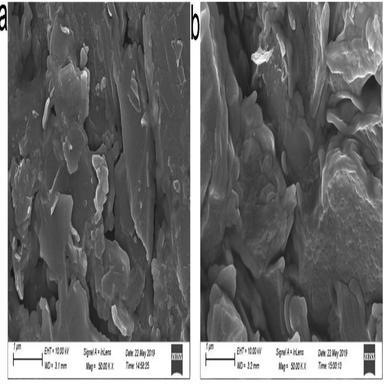
SEM images of (a) SA/MMC1 and (b) SA/MMC3.